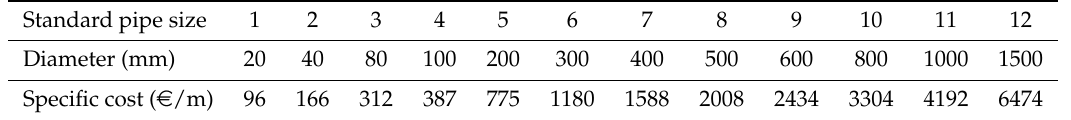
Table A1. Piping cost for standard piping